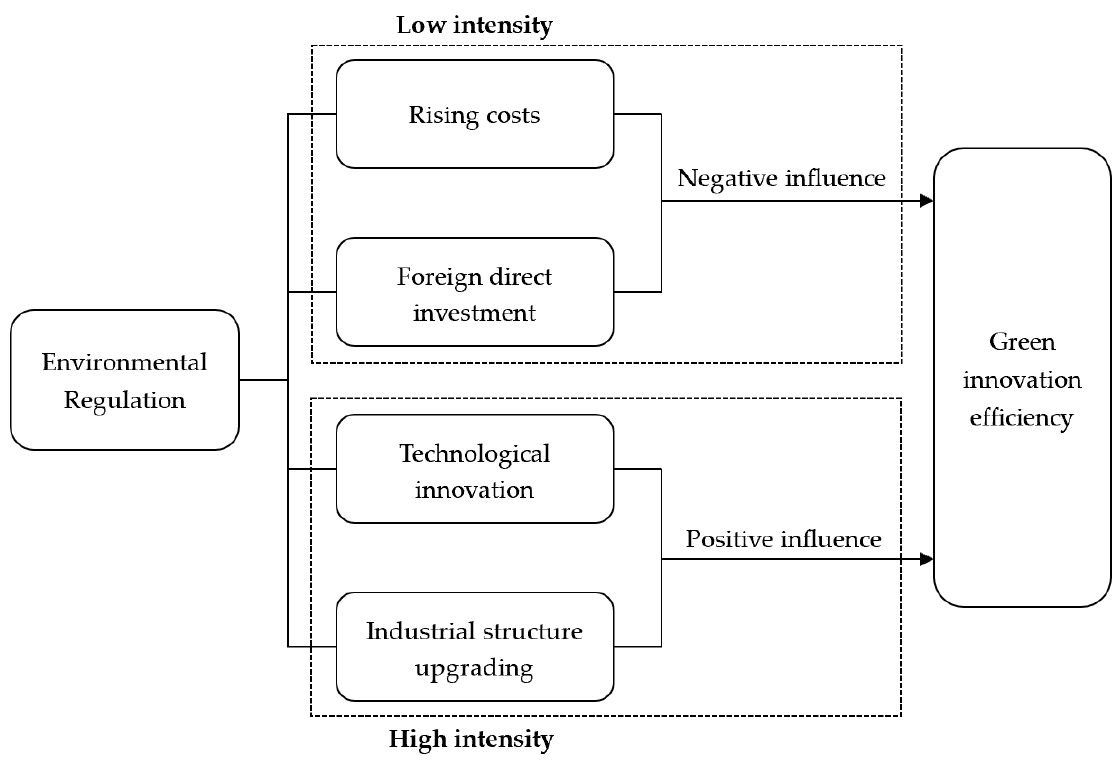
Figure 1. The impact mechanism of environmental regulation on green innovation efficiency.